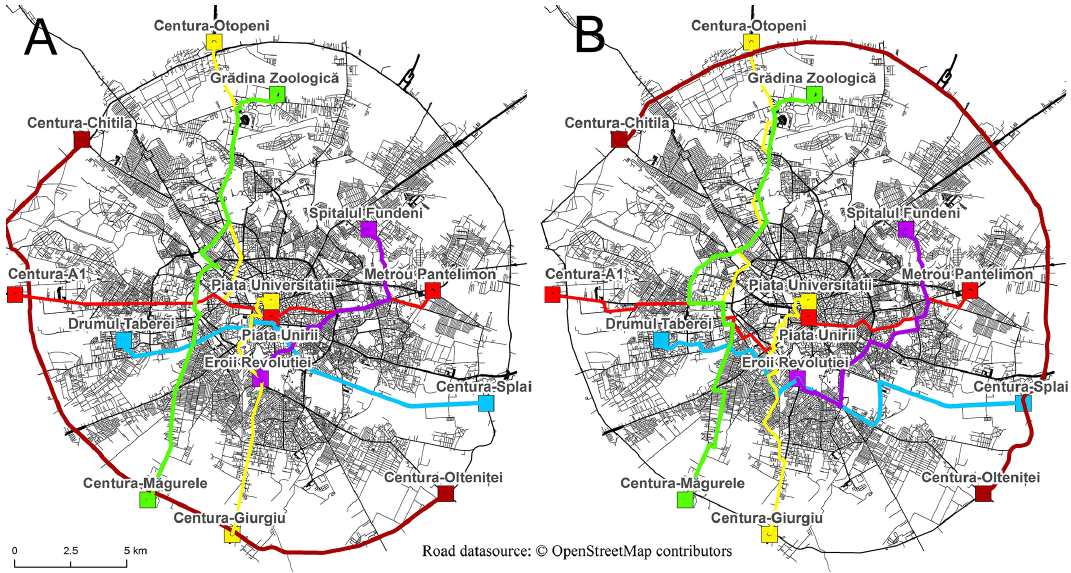
Figure 10. Fastest routes for eight representative OD pairs for Bucharest, for the FT directions, and for the typical traffic scenario on Monday (a) at 02:00LT and (b) 18:00LT. (Road datasource: © OpenStreetMap contributors 2019. Distributed under a Creative Commons BY-SA License; data from September